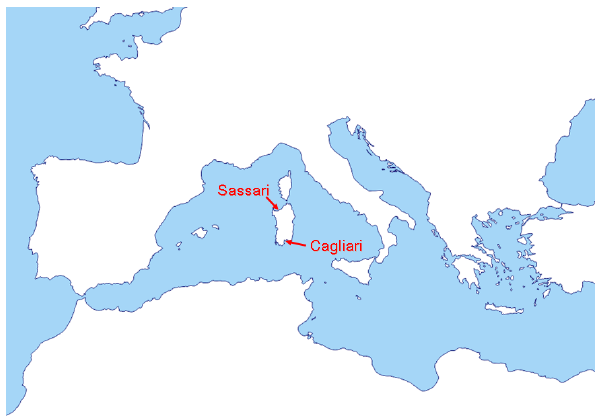
Figure 1. Mediterranean area with Sardinia detail and sampling lo- cations Sassari and